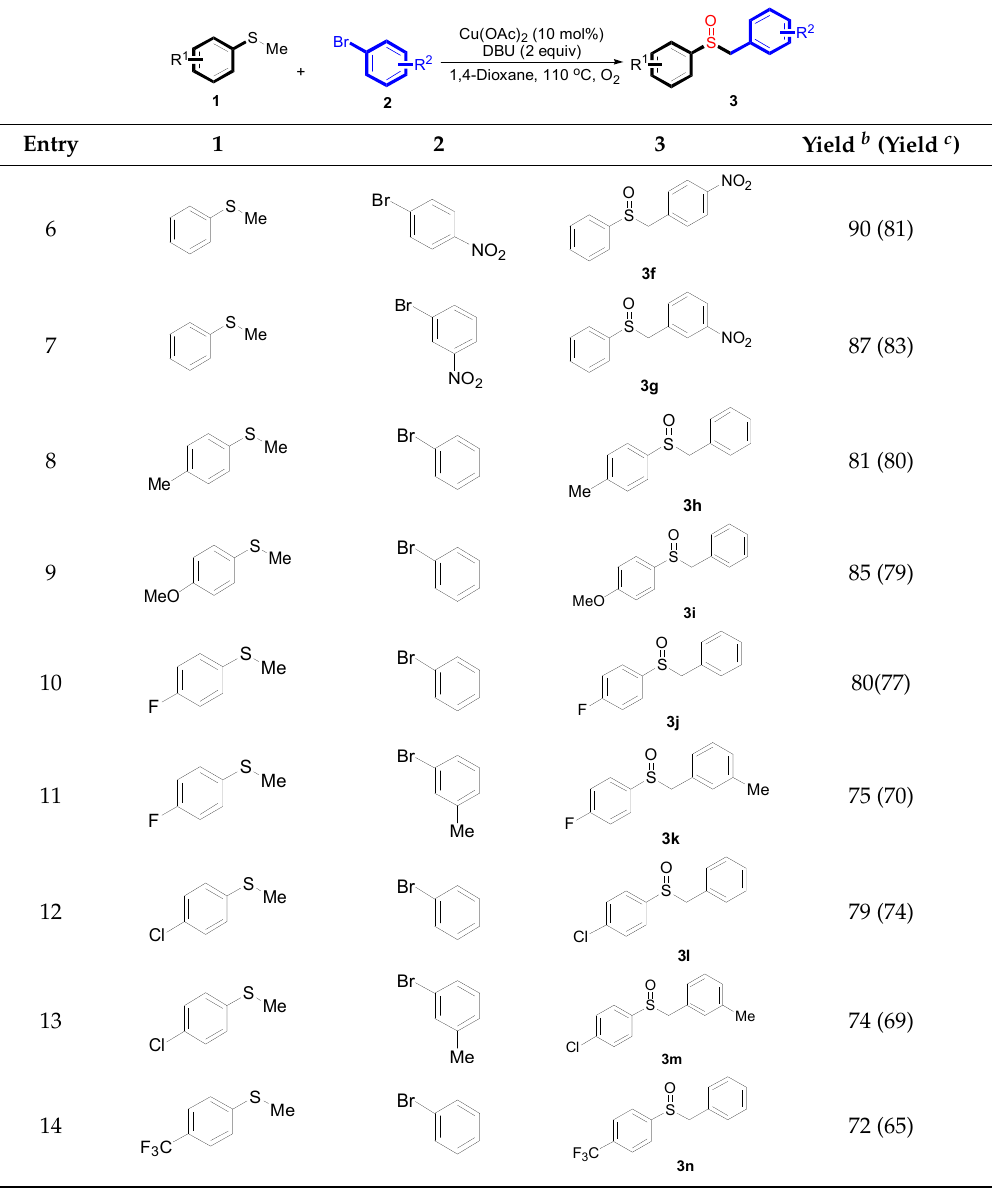
Table 2. Copper-catalyzed sulfoxidation of thioanisoles 1 with bromobenzenes 2 a .